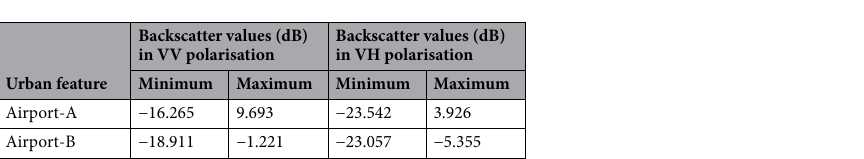
Figure 27. Colour composite image of the Sentinel-1 C-band data, dual-polarization data, and Google Image for site A & B.